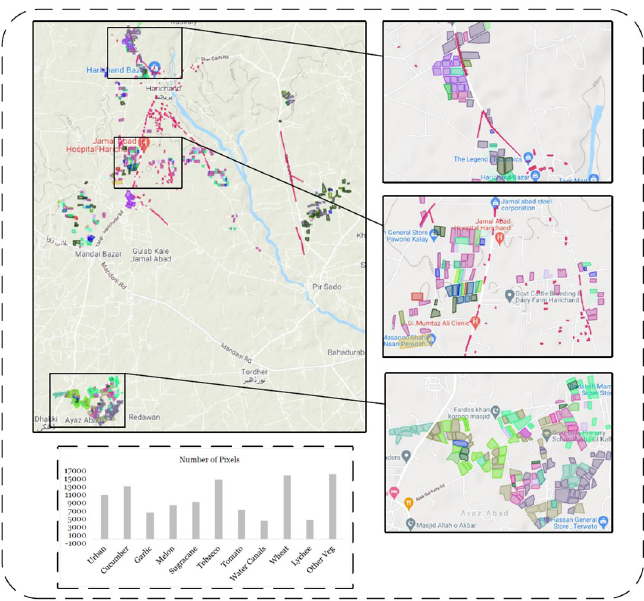
Fig 5. Collected ground truth data (ESRI shapefiles and number of pixels collected during